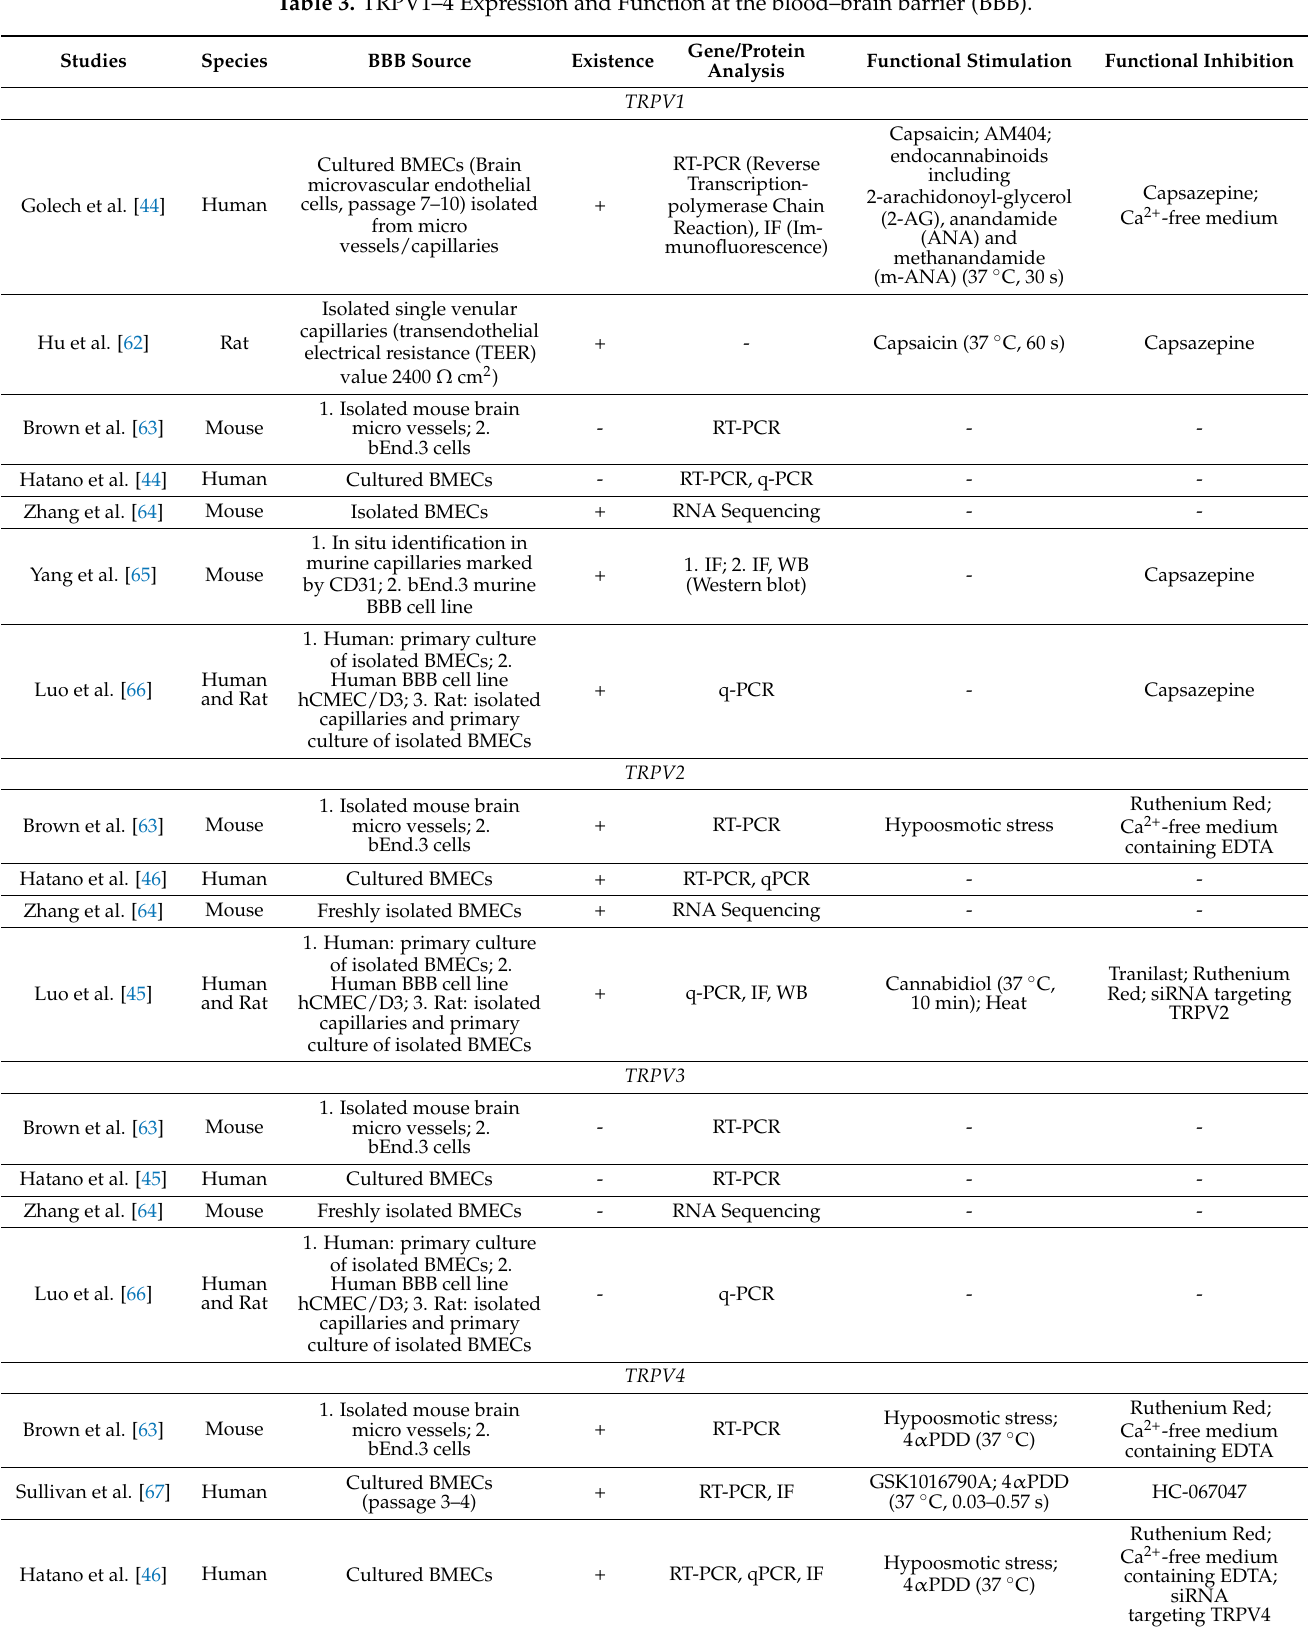
Table 3. TRPV1–4 Expression and Function at the blood–brain barrier